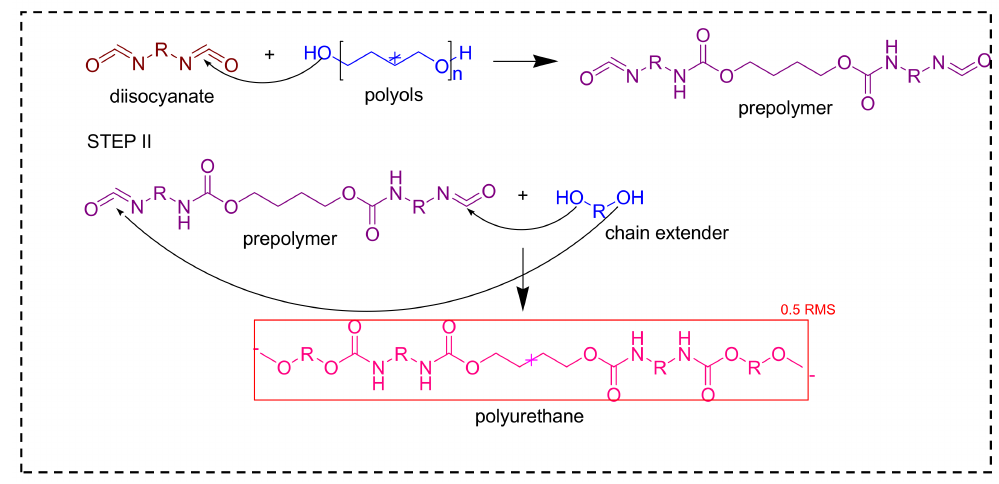
Figure 2. Synthesis of polyurethane in two stages utilizing diisocyanate, polyol, and a chain extender with a low molecular weight